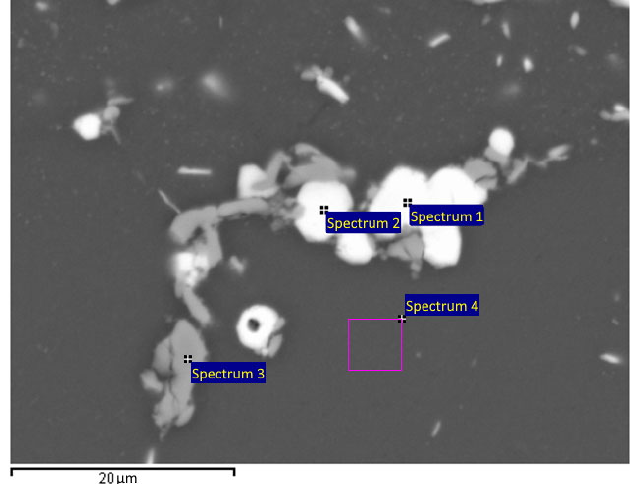
Figure 8. SEM image of the AA 6082/AA 6082 joint brazed according to the 540 °C/30 min mode with EDX measurement points.